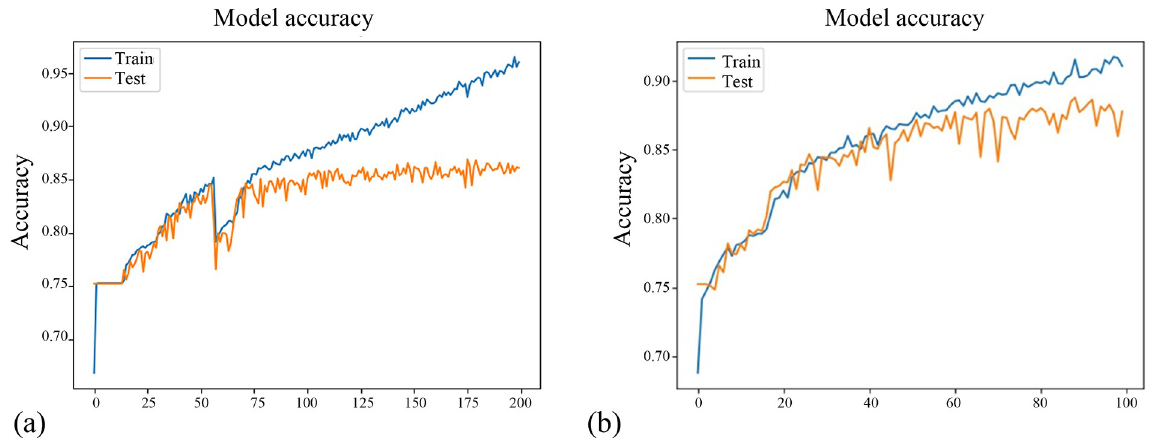
Fig 4. Comparison of variation in iteration accuracy. (a) Model without BN. (b) Model with BN.